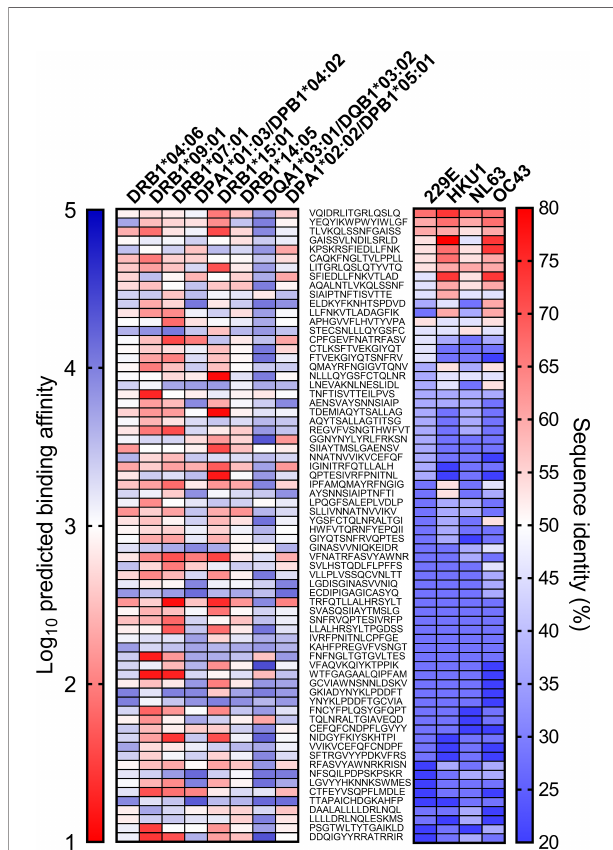
FIGURE 4 | Predicted binding af fi nity and homology of cross-reactive SARS- CoV-2 epitope. The SARS-CoV-2 epitope sequence that was reported previously (middle) and predicted binding af fi nityto the allelein Figures 3 (left). The prediction of binding af fi nity (IC50) was performedwithNetMHCII using the Immune Epitope Database and Analysis Resource (IEDB). Lower binding af fi nitypresented as the red end of the spectrum indicates stronger predicted binding af fi nity. The sequence similarity of commoncold viruses (229E, HKU1, NL63, OC43) to SARS- CoV-2 was expressed as sequence identity(%) and inferredwiththe epitope conservancyanalysis